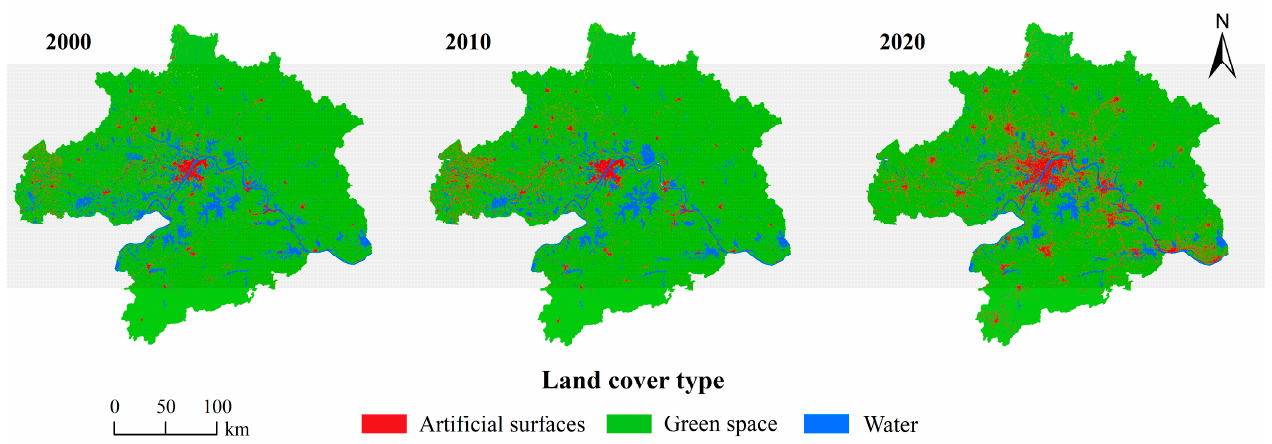
Figure 3. Land cover maps of 2000, 2010 and 2020.